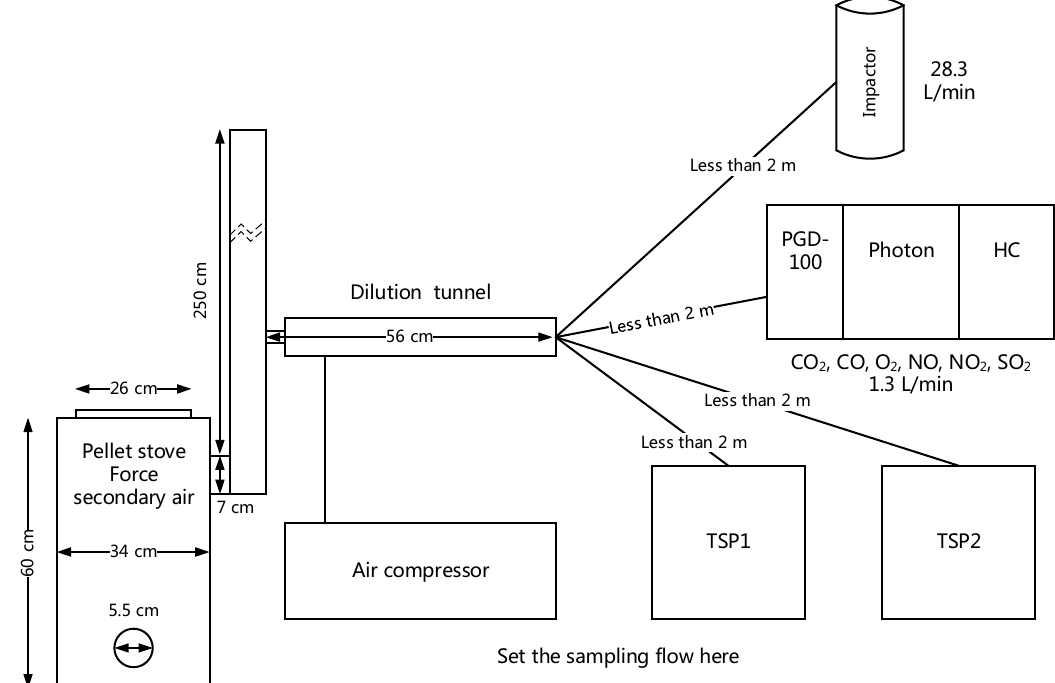
Figure 2. The testing system, including combustion, dilution and data collecting system. The impactor is used for eight-grade of particle size distribution, while two TSP1 and TSP2 are used to test total suspended particulate.